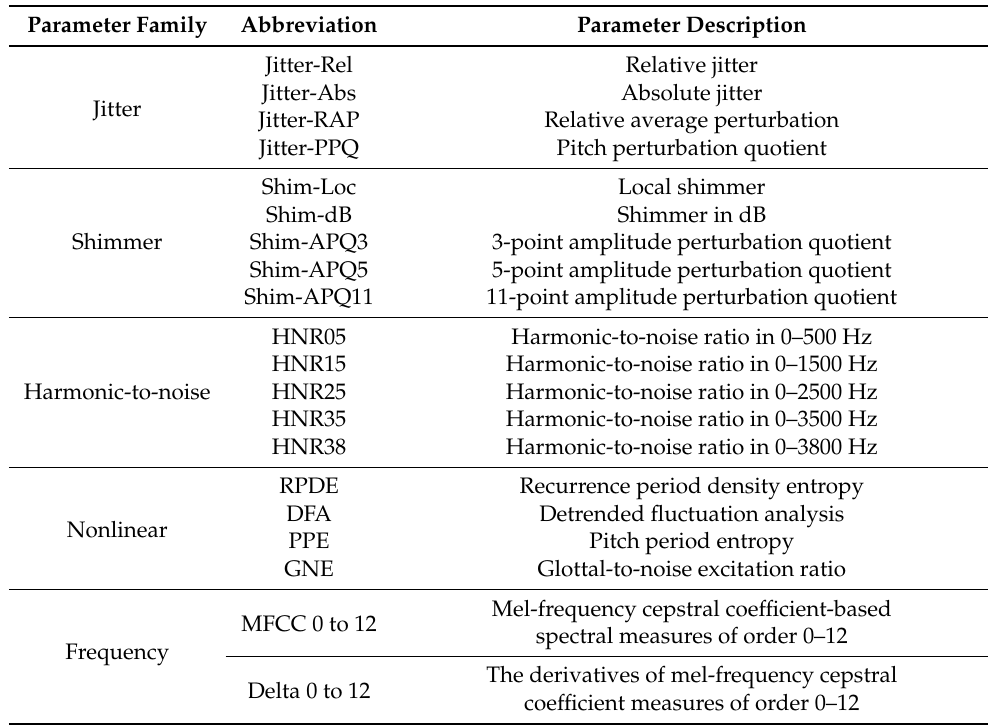
Table 2. Description of acoustic parameter families derived from the voice records in HC and